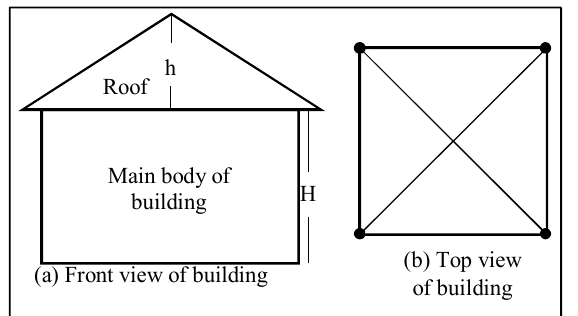
Figure 3. Illustration of a building. In Figure 3, H value stands for the building body height. h value represents the roof height. Black dots represent the intersection of the building boundary